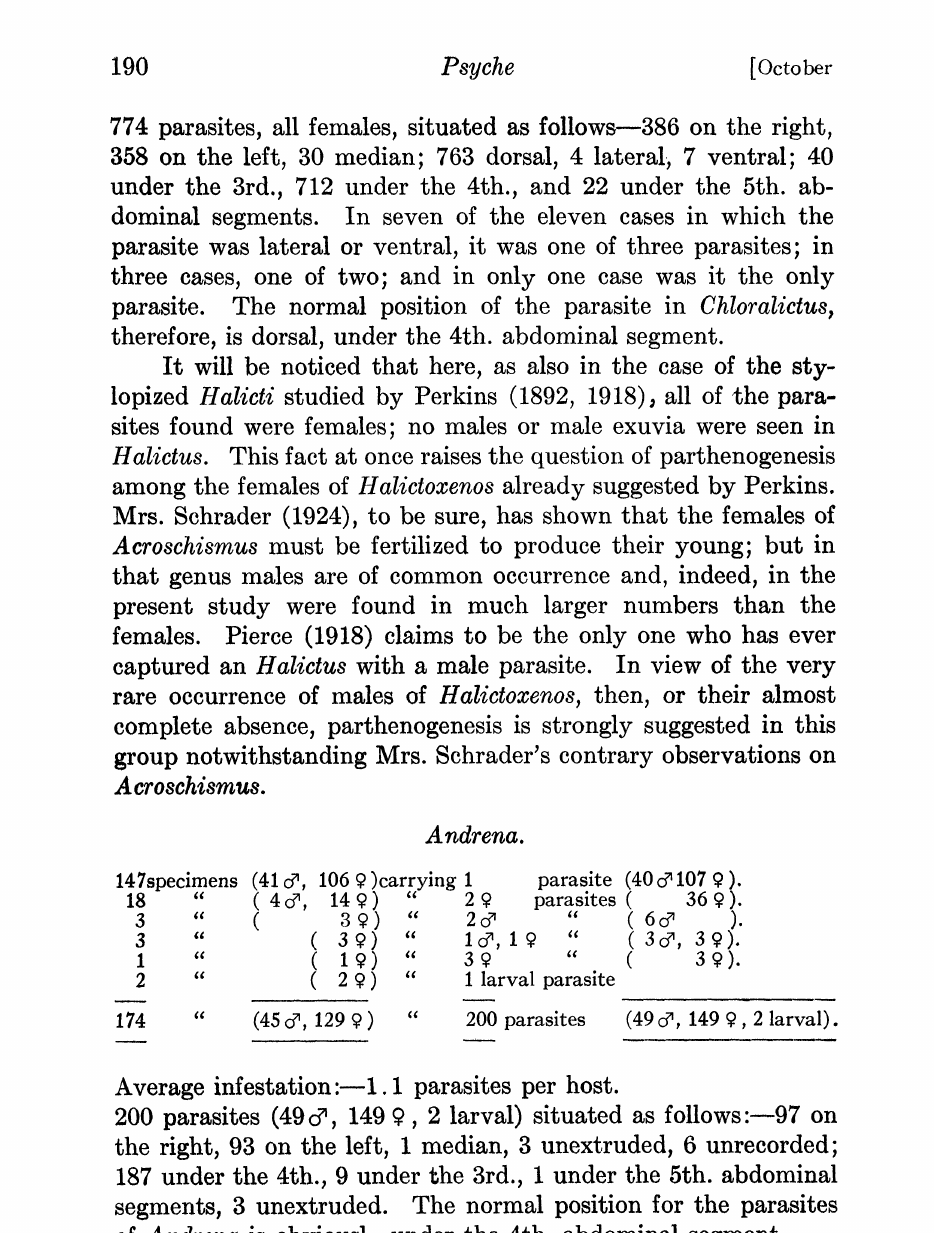
The normal position for the parasites of Andrena is obviously under the 4th. abdominal